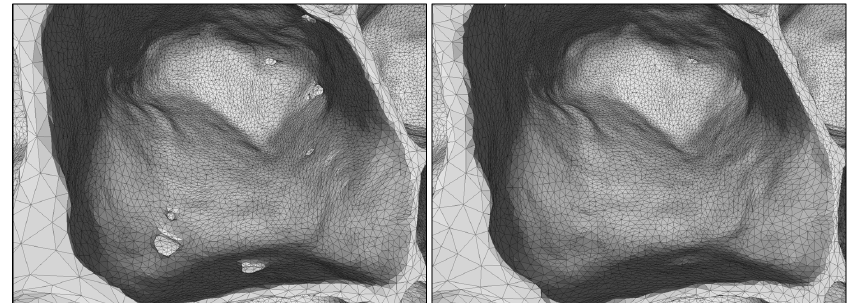
Figure 9. Procedure 1 with defects ( left ) and Procedure 2 without defects ( right